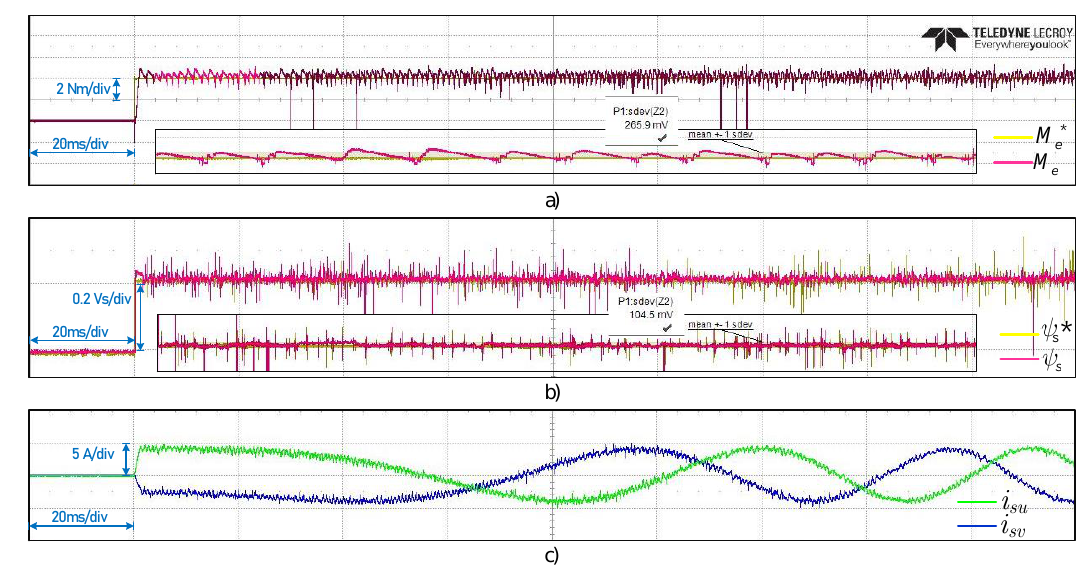
Figure 4. Steady state experimental results of the conventional deadbeat control. ( a ) Electromagnetic torque. ( b ) Stator flux. ( c ) Stator currents.